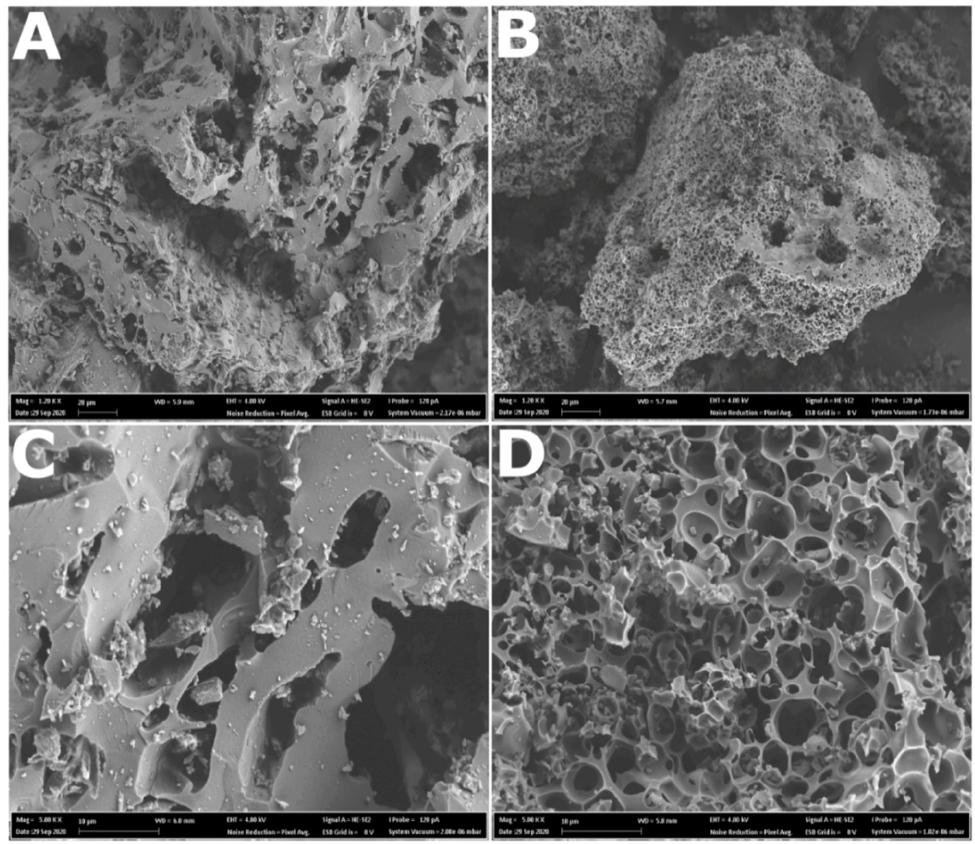
Figure 2. SEM images of BBCs: ( A ) ZnCl 2 -BBC at 1.2 K of magnification, ( B ) KOH-BBC at 1.2 K of magnification, ( C ) ZnCl 2 -BBC at 5 K of magnification, ( D ) KOH-BBC at 5 K of magnification.